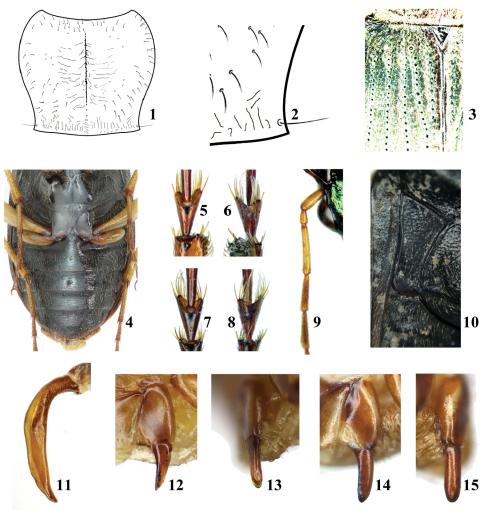
Character states of Chlaenius (Lithochlaenius) spp. Figs 1–13 Chlaenius rambouseki Lutshnik1 pronotum2 site of hind angle seta3 elytral base showing the site of basal pore4 abdominal sterna showing the pubescence5 male anterior tarsomere 4 in dorsal view6 male anterior tarsomere 4 in ventral view7 female anterior tarsomere 4 in dorsal view8 female anterior tarsomere 4 in ventral view9 antennomeres 1–5 showing antennomere 3 distinctly longer than 1 and 2 ones combined10 metepisternum11 aedeagus, showing the basic structure of the aedeagus in Lithochlaenius species12 female gonostylus in ventral view13 female gonostylus in lateral view14 female gonostylus of Chlaenius propeagilis sp. n. in ventral view15 female gonostylus of Chlaenius propeagilis sp. n. in lateral view.